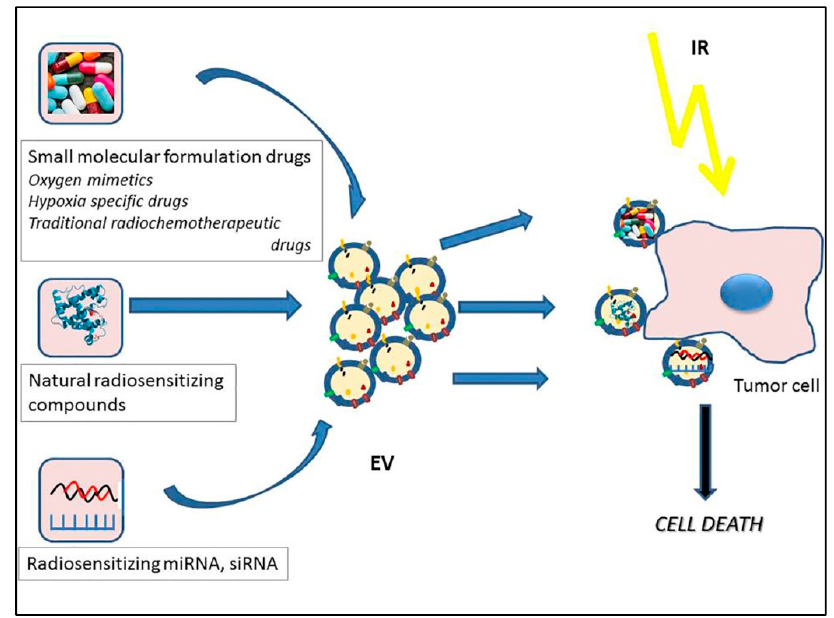
Figure 4. Schematic diagram depicting the potential roles of extracellular vesicles as nanocarriers for radiosensitizing agents.